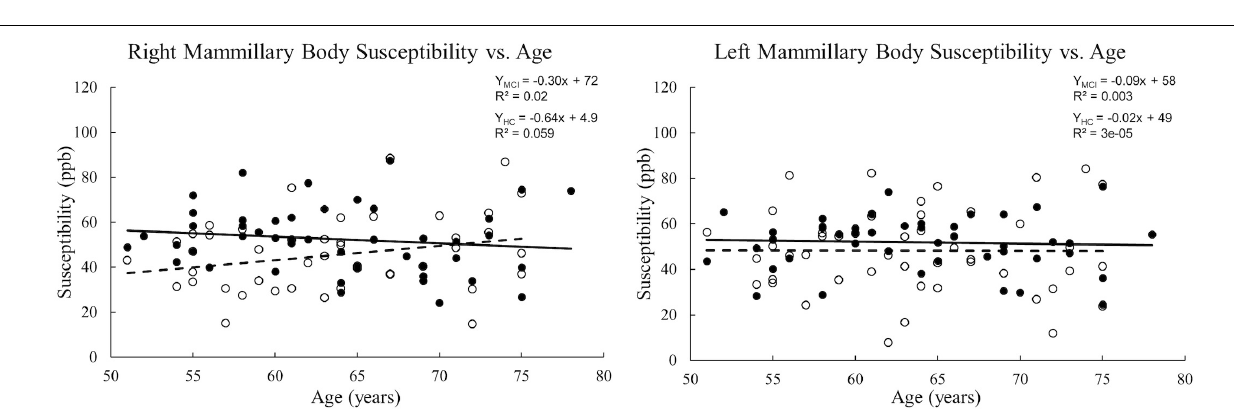
Frontiers in Neuroscience |